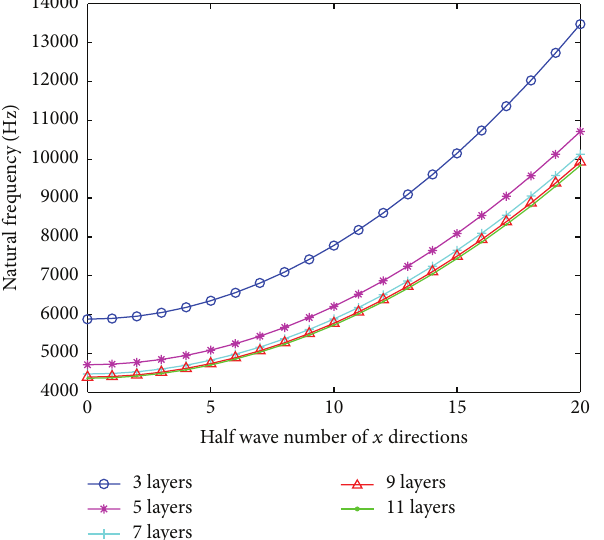
Figure 11: The natural frequency of constrained damping plate with various layers ( 𝑛 = 20 ).